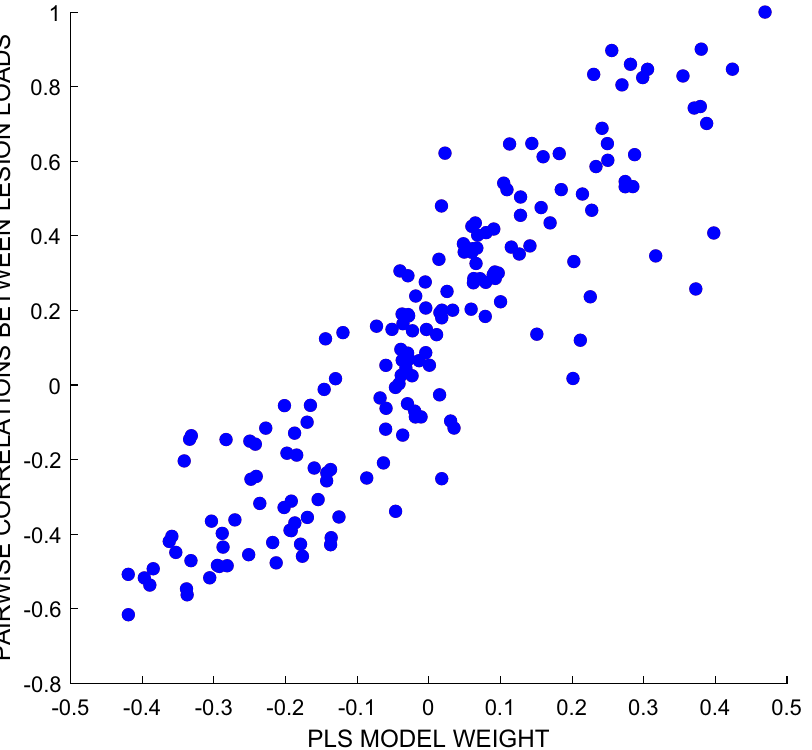
Figure 3. Scatter plot relating: (i) coefficients of the pairwise correlations between lesion load values in primary auditory cortex area TE11, and lesion loads in all of the 177 brain regions that we considered (y-axis); to (ii) the weights assigned to each of those same brain regions by our best PLS regression model, as derived via data perturbation (described in the Methods). The strong correlation between these two quantities implies that lesser lesion load in primary auditory cortex area TE11 serves as a proxy for greater lesion load in areas where that extra damage most strongly predicts poorer treatment